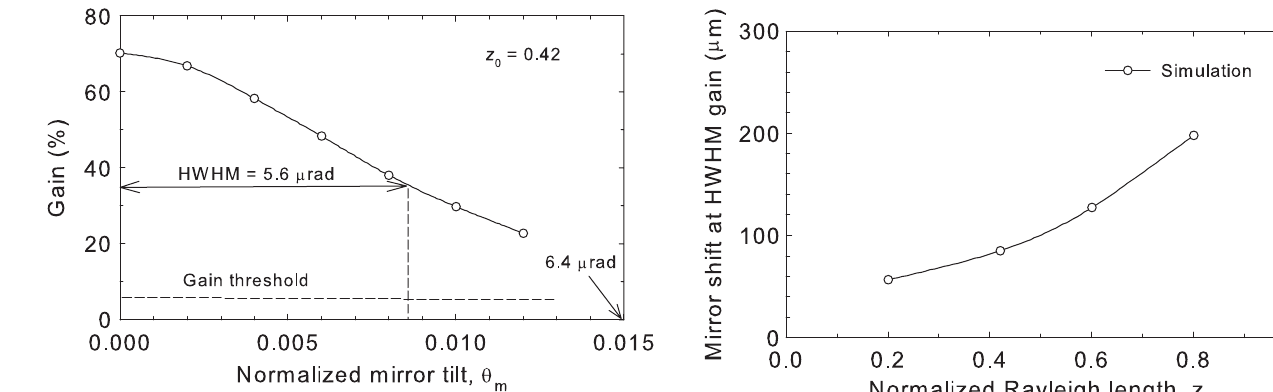
FIG. 7. Mirror shift at HWHM gain versus z 0